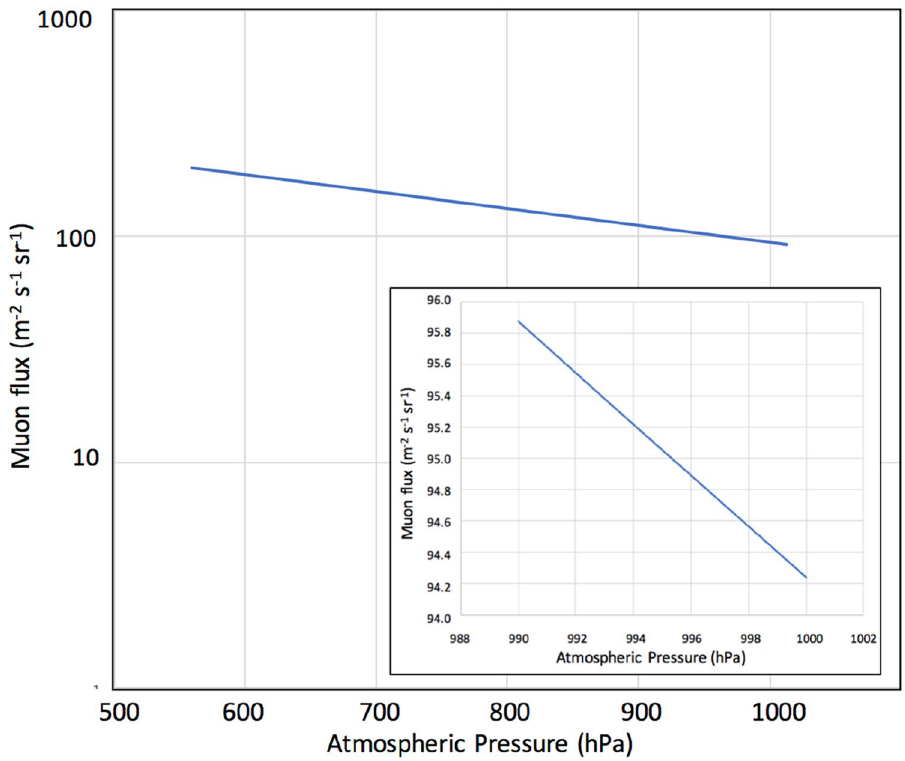
Figure 1. Vertical muon flux (N) versus atmospheric pressure ( ρ ). Inset illustrates the atmospheric pressure within the range between 990 and 1000 hPa.